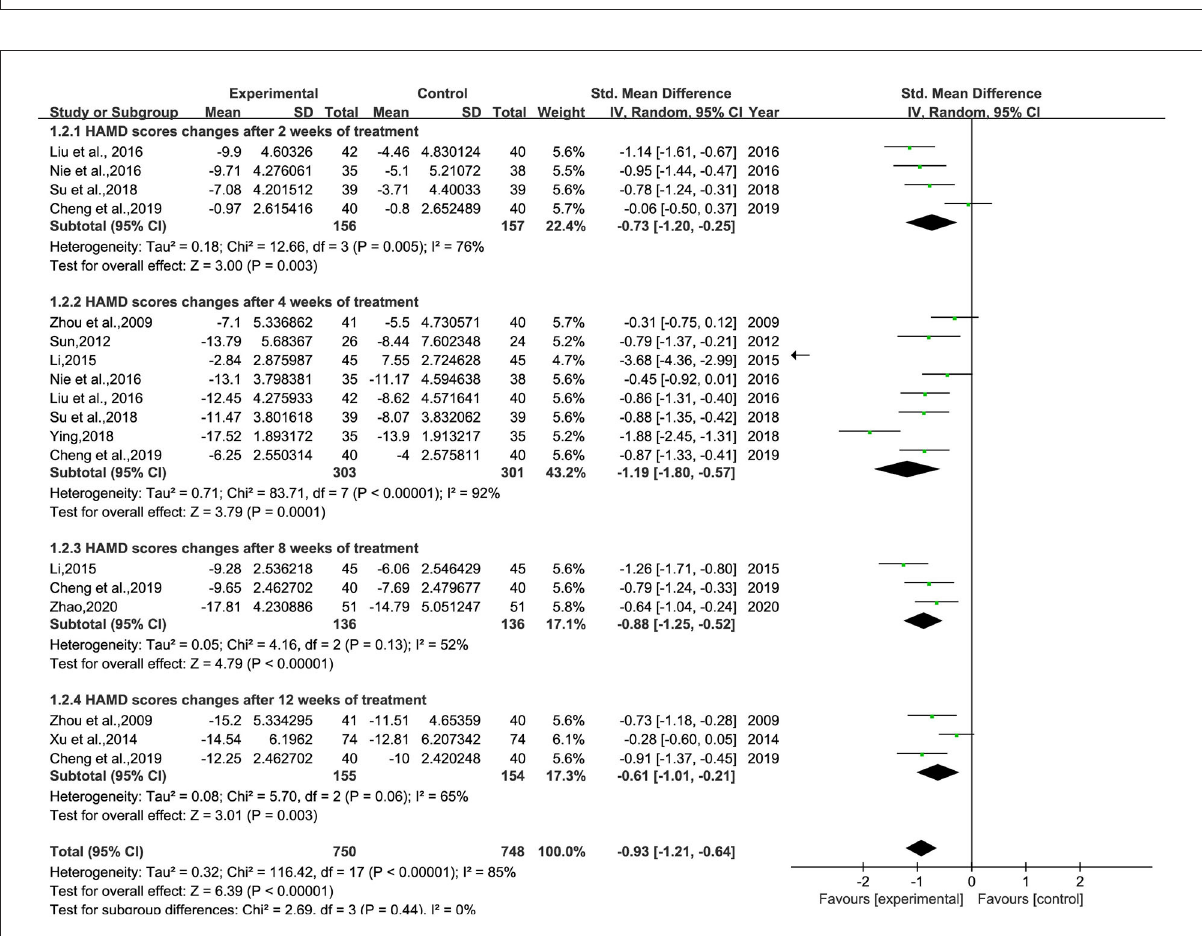
FIGURE4 Meta-analysis of BHD and antidepressant medication cycles on HAMD change values. Green: Continuous.